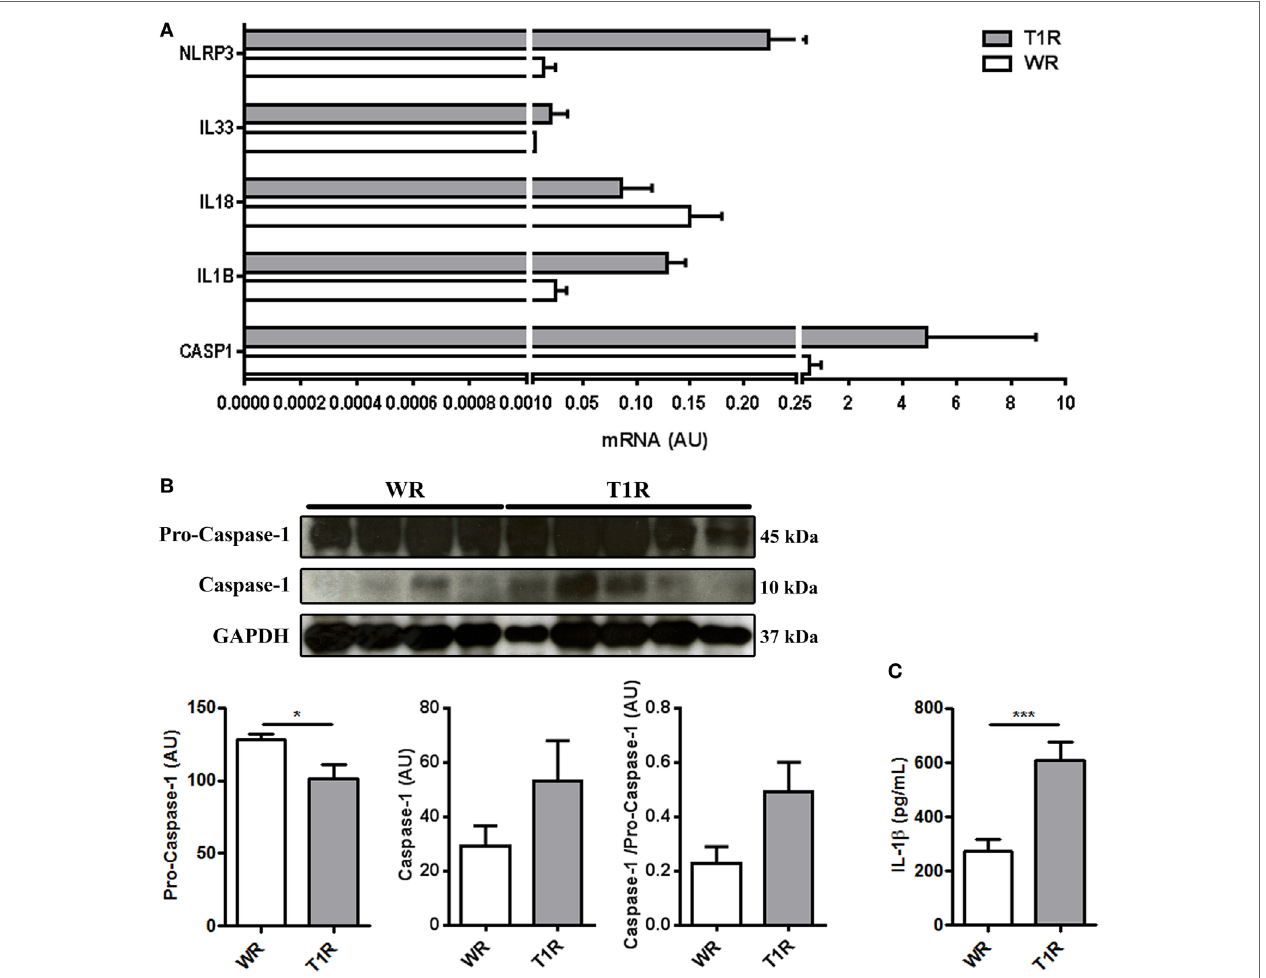
FigUre 4 | Leprosy lesions present a modulation of inflammasome-associated genes, the subunits of caspase-1 protein, and IL-1 β secretion between multibacillary patients who developed (T1R) or not (WR) reversal reactional episodes in the future. (a,b) Skin lesion samples were obtained from multibacillary patients who developed (T1R) or not (WR) reversal reactional episodes and analyzed as indicated. (a) Purified mRNAs from skin lesions of multibacillary patients who developed or not T1R episodes were analyzed by RT-qPCR for NLRP3 , IL33 , IL18 , IL1B , and CASP1 . Bars represent the mean values ± SEM of three patients of each group. (b) Increased activity of caspase-1 in T1R patients skin lesion. Protein contents from leprosy lesions were analyzed by immunoblotting with anti-caspase-1. Glyceraldehyde-3-phosphate dehydrogenase (GAPDH) was used to verify protein amount loading. Blots are shown (WR, n = 4; T1R, n = 5). Densitometric analysis of the blots was performed and the caspase-1 (p10 subunit) and pro-caspase-1 (p45 subunit)/GAPDH ratios are expressed as arbitrary units (AU). Data are presented as mean ± SEM. * p < 0.05. (c) The IL-1 β levels were assessed in the sera of multibacillary patients who developed (T1R) or not (WR) reversal reaction episodes by ELISA. Bars represent the mean values ± SEM (WR, n = 10; T1R, n = 12). *** p <